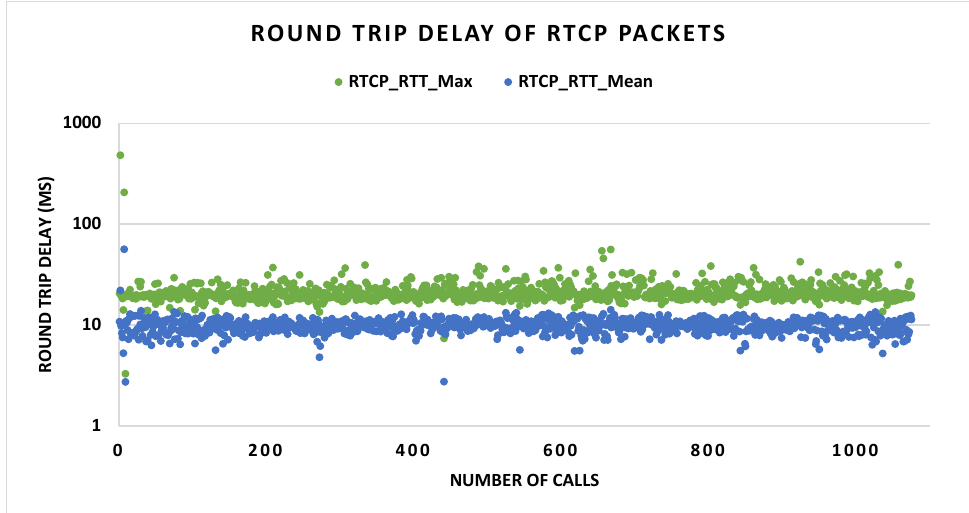
Figure 8. Evaluation of round-trip delay of the RTCP packets.